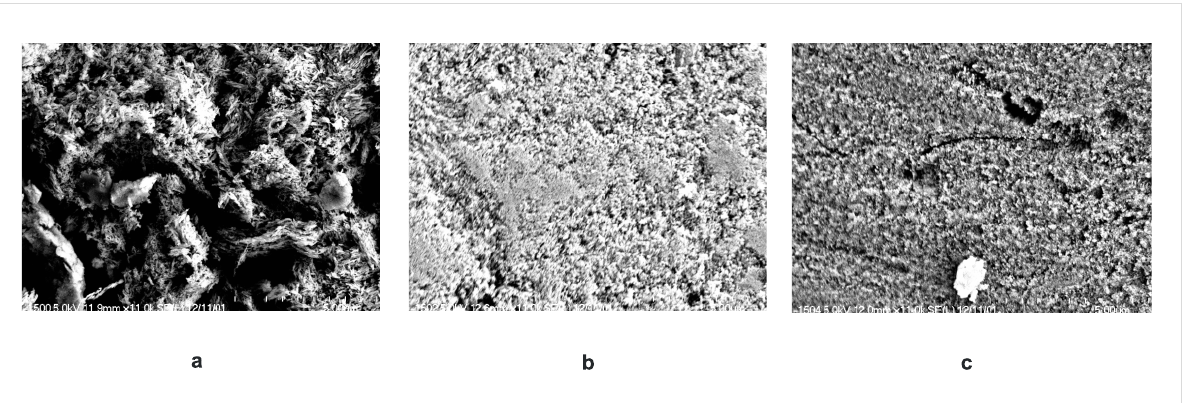
Figure 2: Etch pattern of enamel etched with a) Conditioner 36, magnification 11 × 10 3 , b) acidic monomer 3g ( c = 0.5 mol/l) in ethanol/water 1:1, magnification 11 × 10 3 , c) Clearfil SE Primer, magnification 11 × 10 3 .